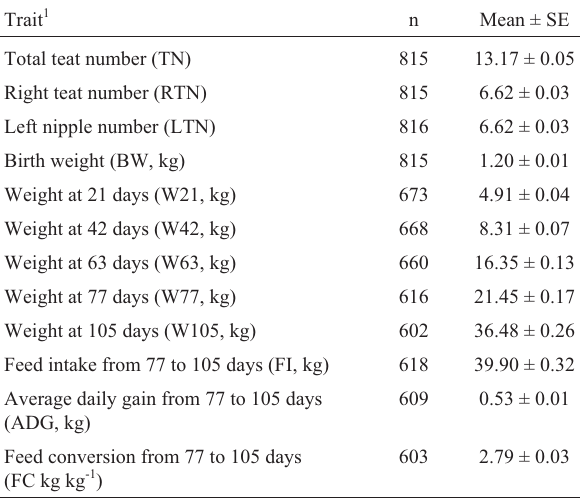
Table 1 - Number of F2 offspring (n) analyzed, mean and standard error (SE) with each performance trait. Trait